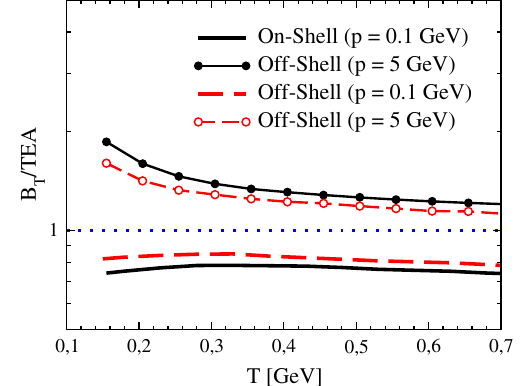
Fig. 5 B T / T E A as a function of temperature for both on-shell and off-shell approaches and p = 0 . 1 GeV and p = 5 GeV. Same legend as in Fig. 4